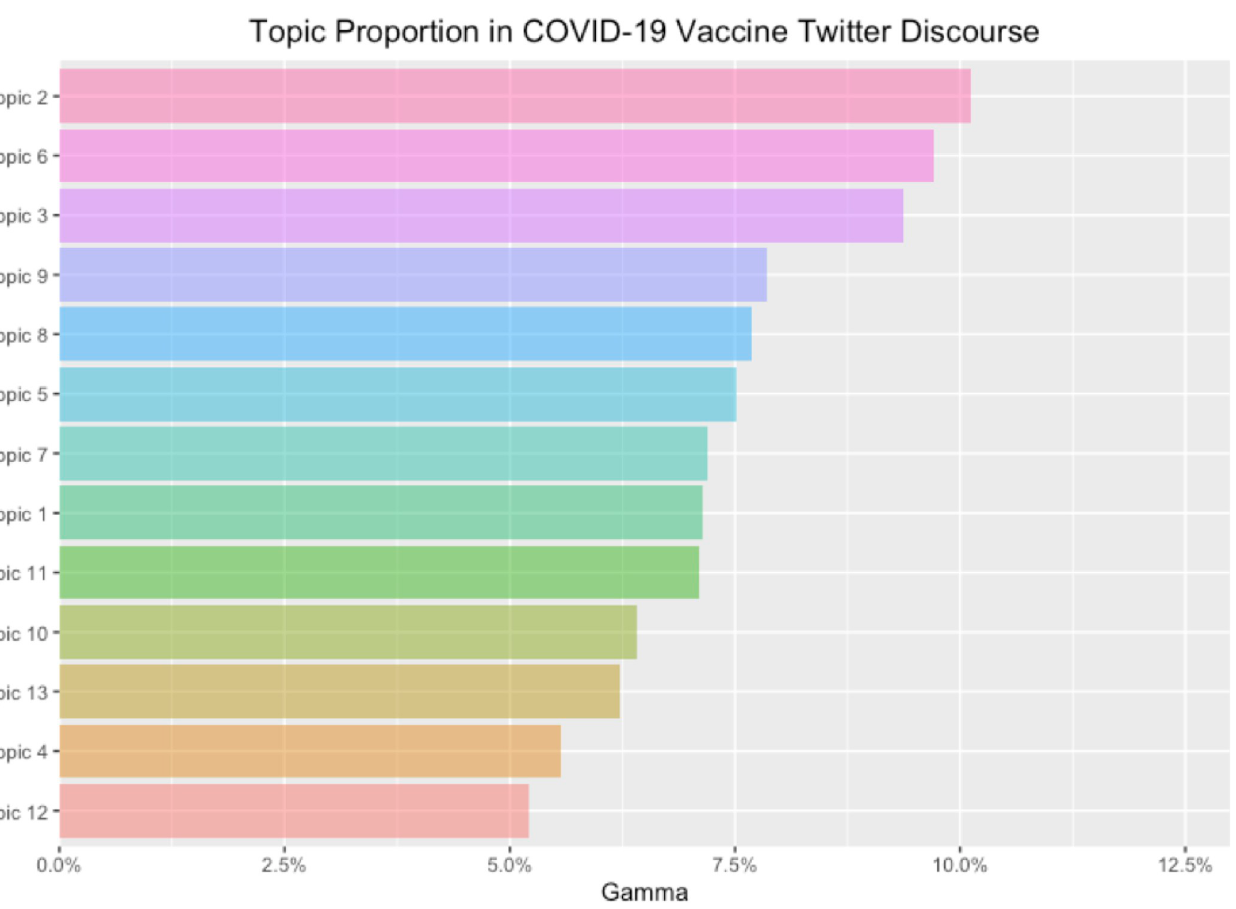
Fig 2. The average gamma value for each topic ( γ ). The document-topic probability, or the gamma value, is the estimated proportion of words from a given document that are generated from that topic.